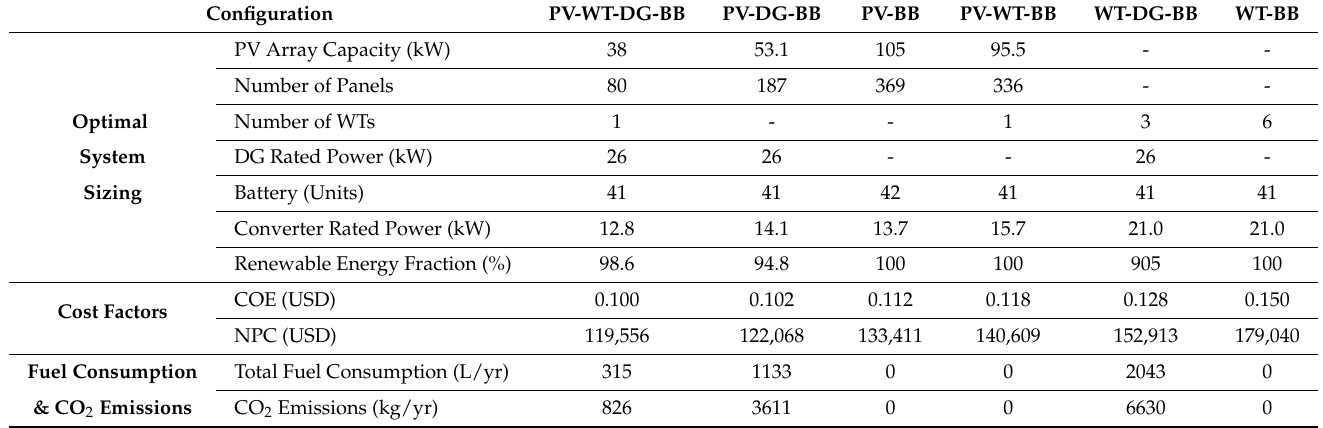
Table 11. Simulation Results for Jal-Alayah Cell Site—Case 2.